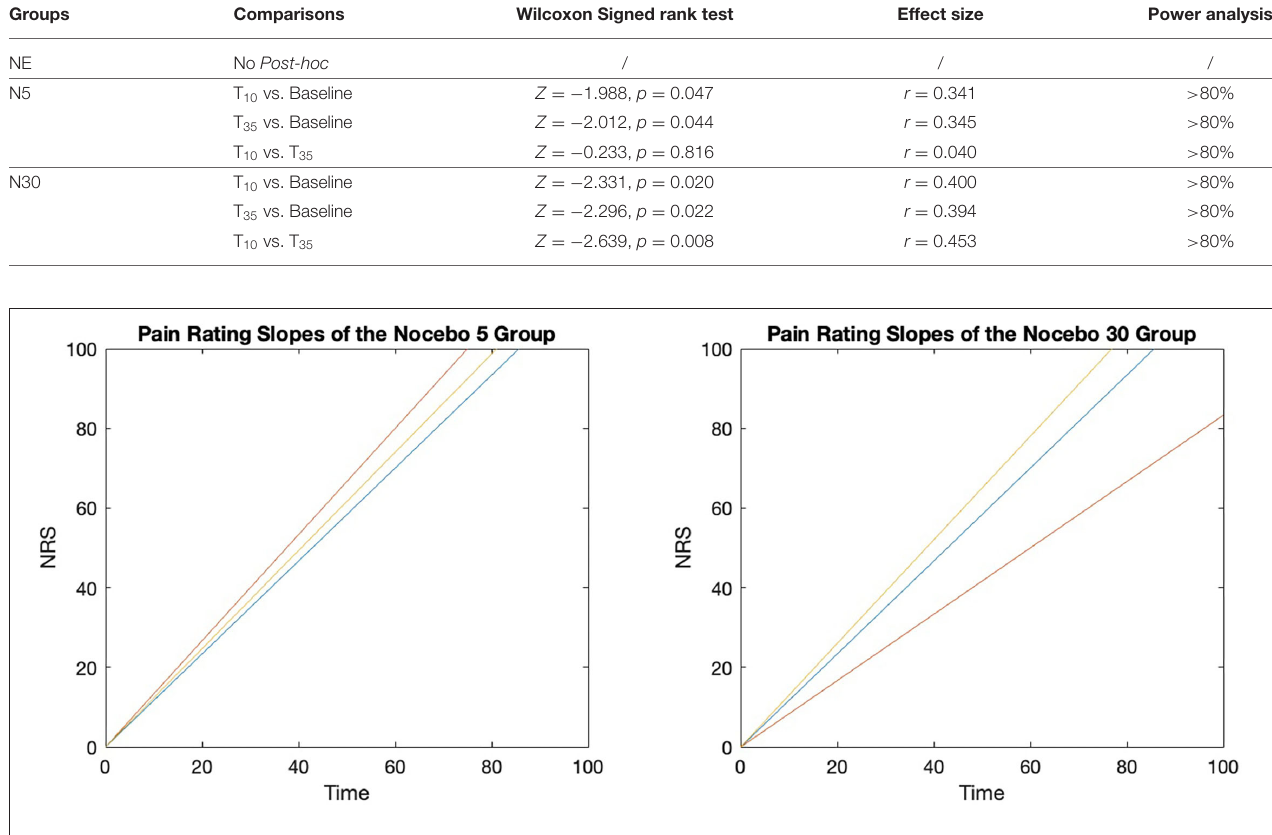
TABLE 5 | Within-group comparison of the slope of pain ratings. Groups